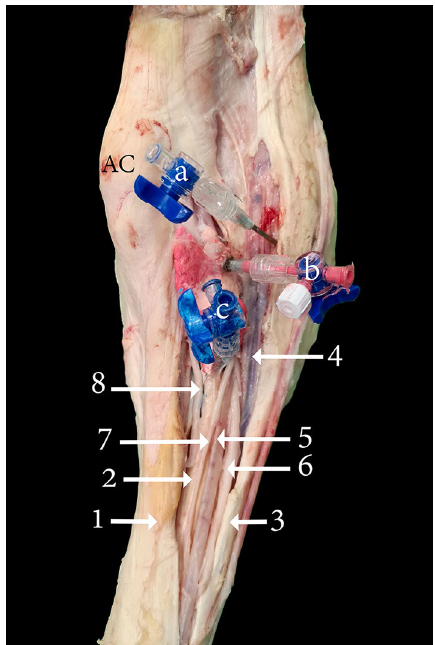
Figure 9. Palmar view of the left carpal joint, showing (a) the palmar medial and (b) palmar lateral arthrocentesis approach for the radiocarpal joint, and (c) the palmar approach for the carpometacarpal joint. AC, accessory carpal bone; 1, superficial digital flexor muscle; 2, deep digital flexor tendon; 3, interosseous medius muscle; 4, median vein; 5, median artery; 6, common palmar nerve of digit III; 7, common palmar nerve of digit IV; 8, ulnar nerve.